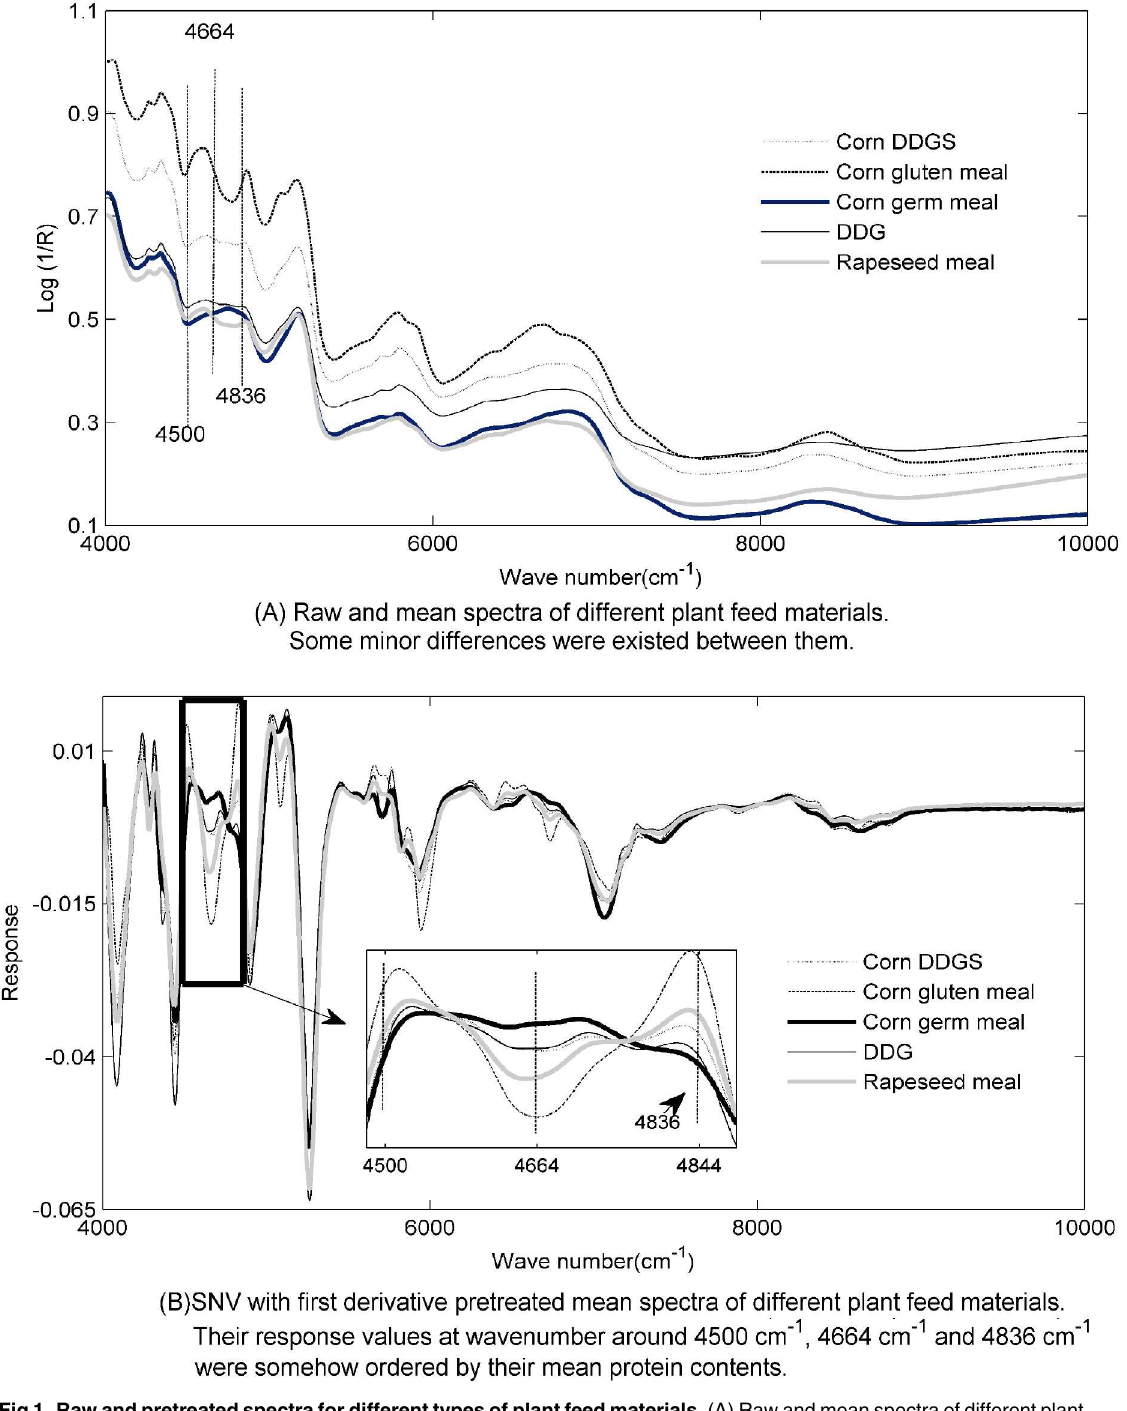
Fig 1. Raw and pretreated spectra for different types of plant feed materials. (A) Raw and mean spectra of different plant feed materials. Some minor differences were existed between them. (B) SNV with first derivative pretreated mean spectra of different plant feed materials. Their response values at wavenumber around 4500 cm -1 , 4664 cm -1 and 4836 cm -1 were somehow ordered by their mean protein contents.